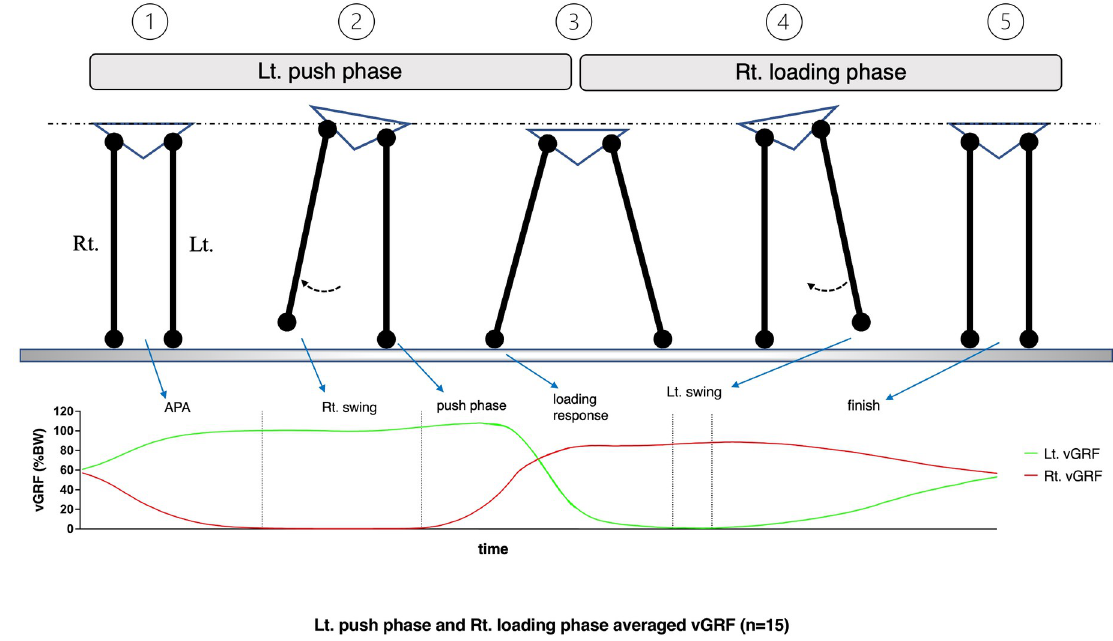
Fig 2. “Step-aside to the right” movement sequence was divided into two phases: The “left push” phase and the “right loading” phase. According to the method by Yiou et al., each phase was further divided into three periods [20].